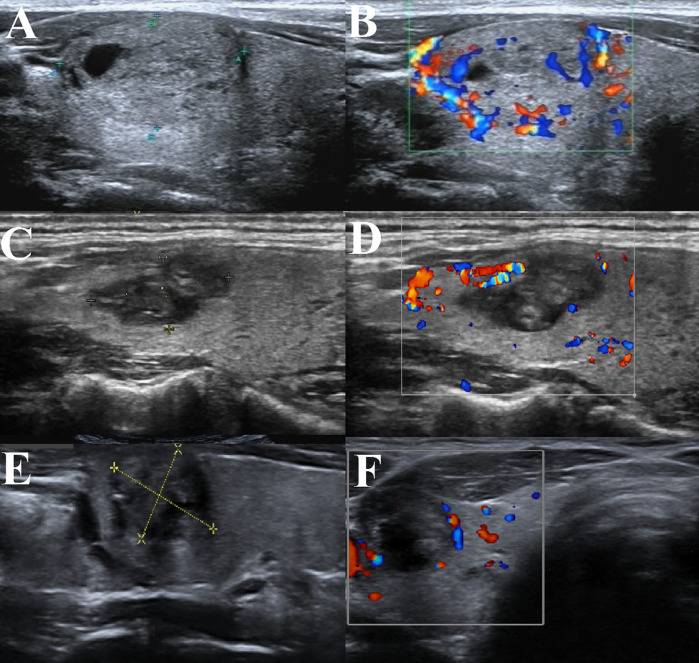
BTN volume reduction of a patient in our hospital undergoing thyroid thermal ablation. (A) BTN before thyroid ablation; (B) Perfusion signal of the BTN before ablation; (C) The same BTN at 3 months after ablation; (D) Perfusion signal of the BTN at 3 months after ablation; (E) The same BTN at 6 months after ablation; (F) Perfusion signal of the BTN at 6 months after ablation.